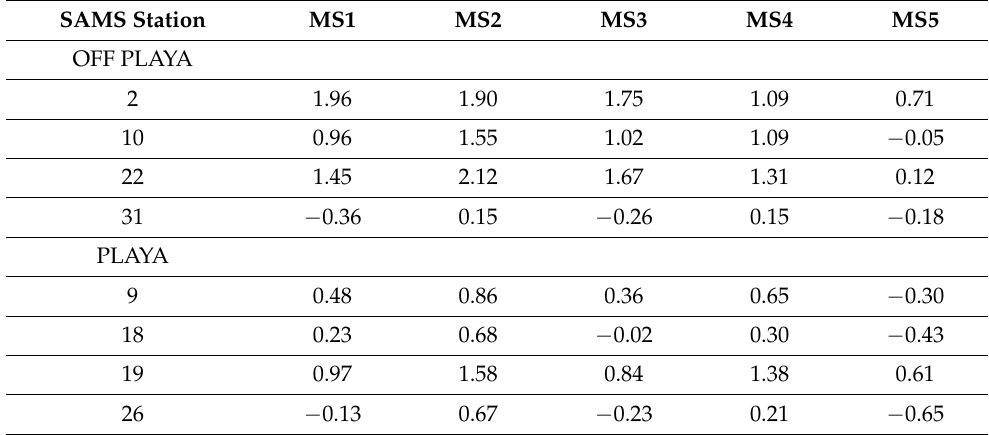
Table 2. Aggregate 2 m AGL temperature mean bias values for each model setup.